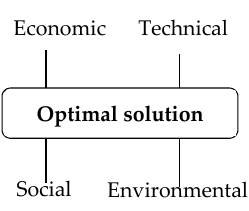
Figure 3. BMP selection criteria.